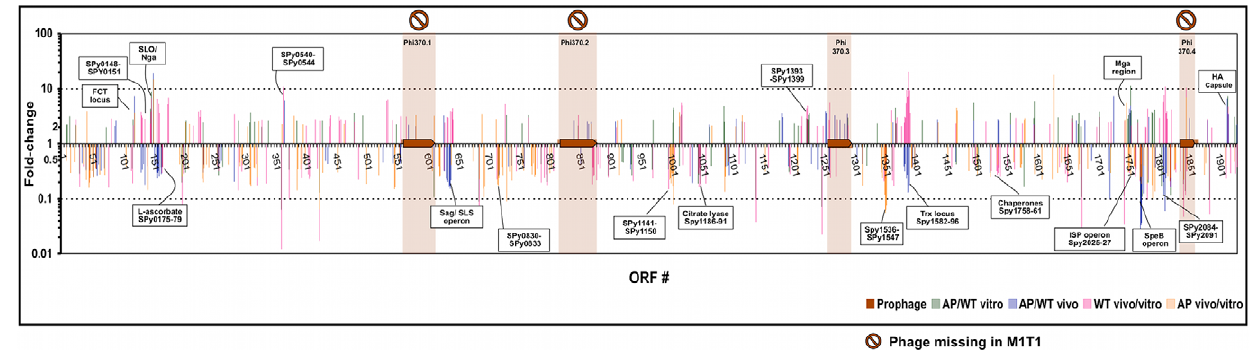
Figure 3. Neighbor clustering of significantly differentially expressed genes mapped to M1 SF370 genome. Fold-change ratios of significantly differentially expressed genes (P , 0.05) are mapped to ORFs of the M1 SF370 genome (the M1 strain used as core for the microarray). SF370 prophages are shown, including those absent in M1T1. The graph shows sets of contiguous genes with similar coexpression patterns. A higher resolution version of the figure is provided online as Figure